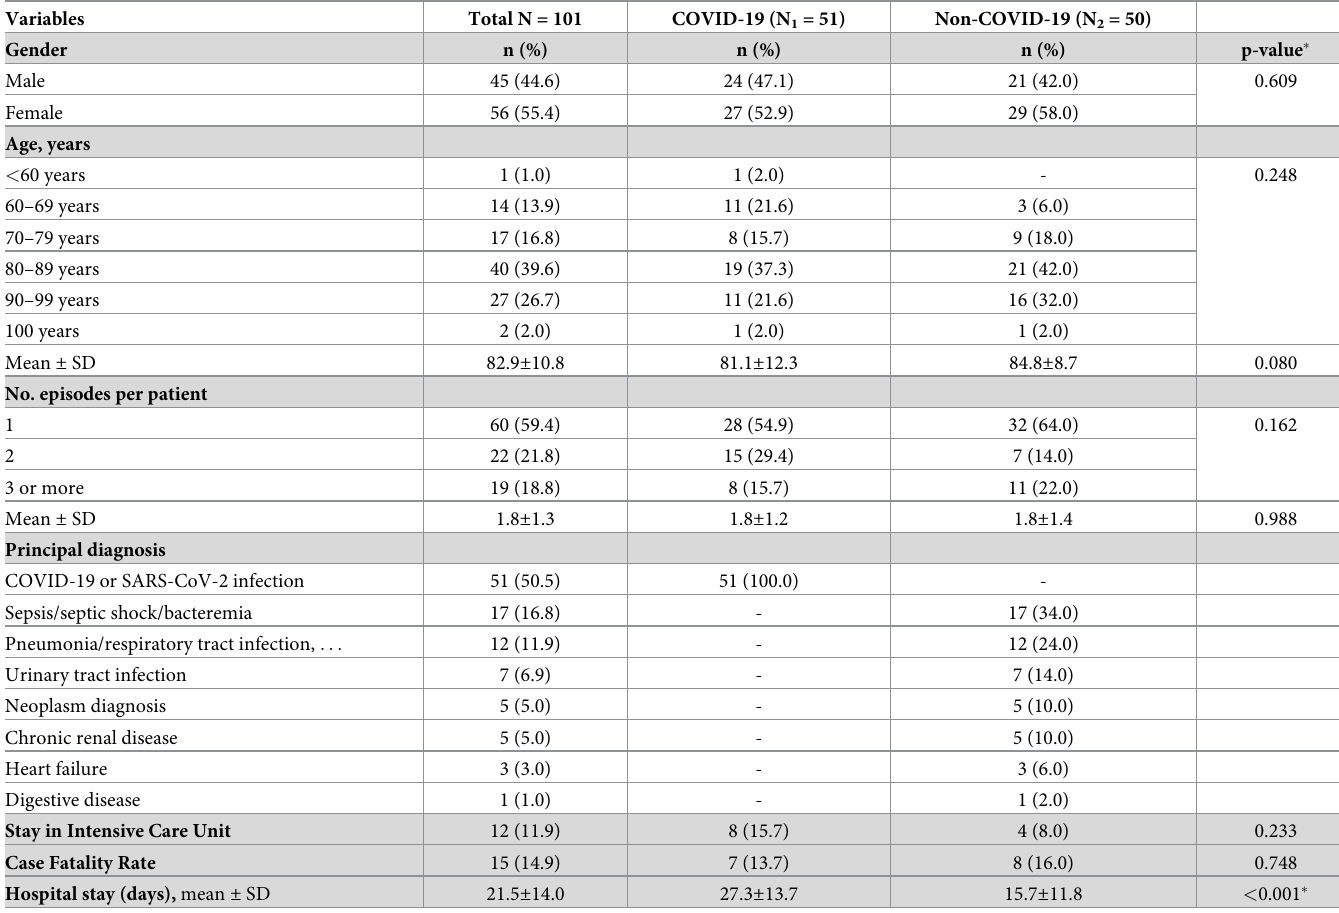
Table 1. Patient cohort